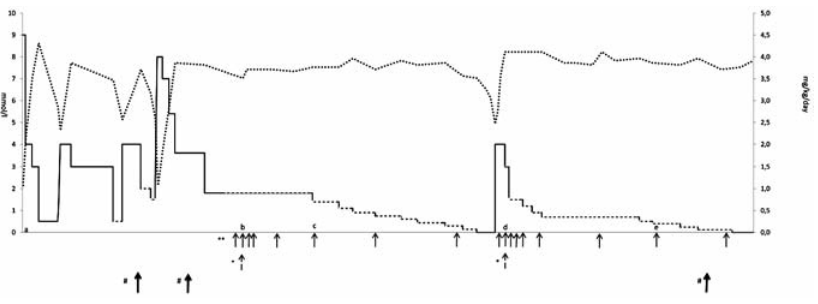
1. Time schedule of patient’s history. Dotted line: hemoglobin (mmol/L). Prednisone (mg/kg/day) uninterrupted line; prednisone (mg/kg every other day) inter- rupted line. Arrows: *rituximab treatment; ** blood sample (resp t = 0, 8, 14, 21, 56, 110, 202, 321, 383, 396, 403, 410, 418, 446, 530, 614, 718, 817, 1085 days after the first